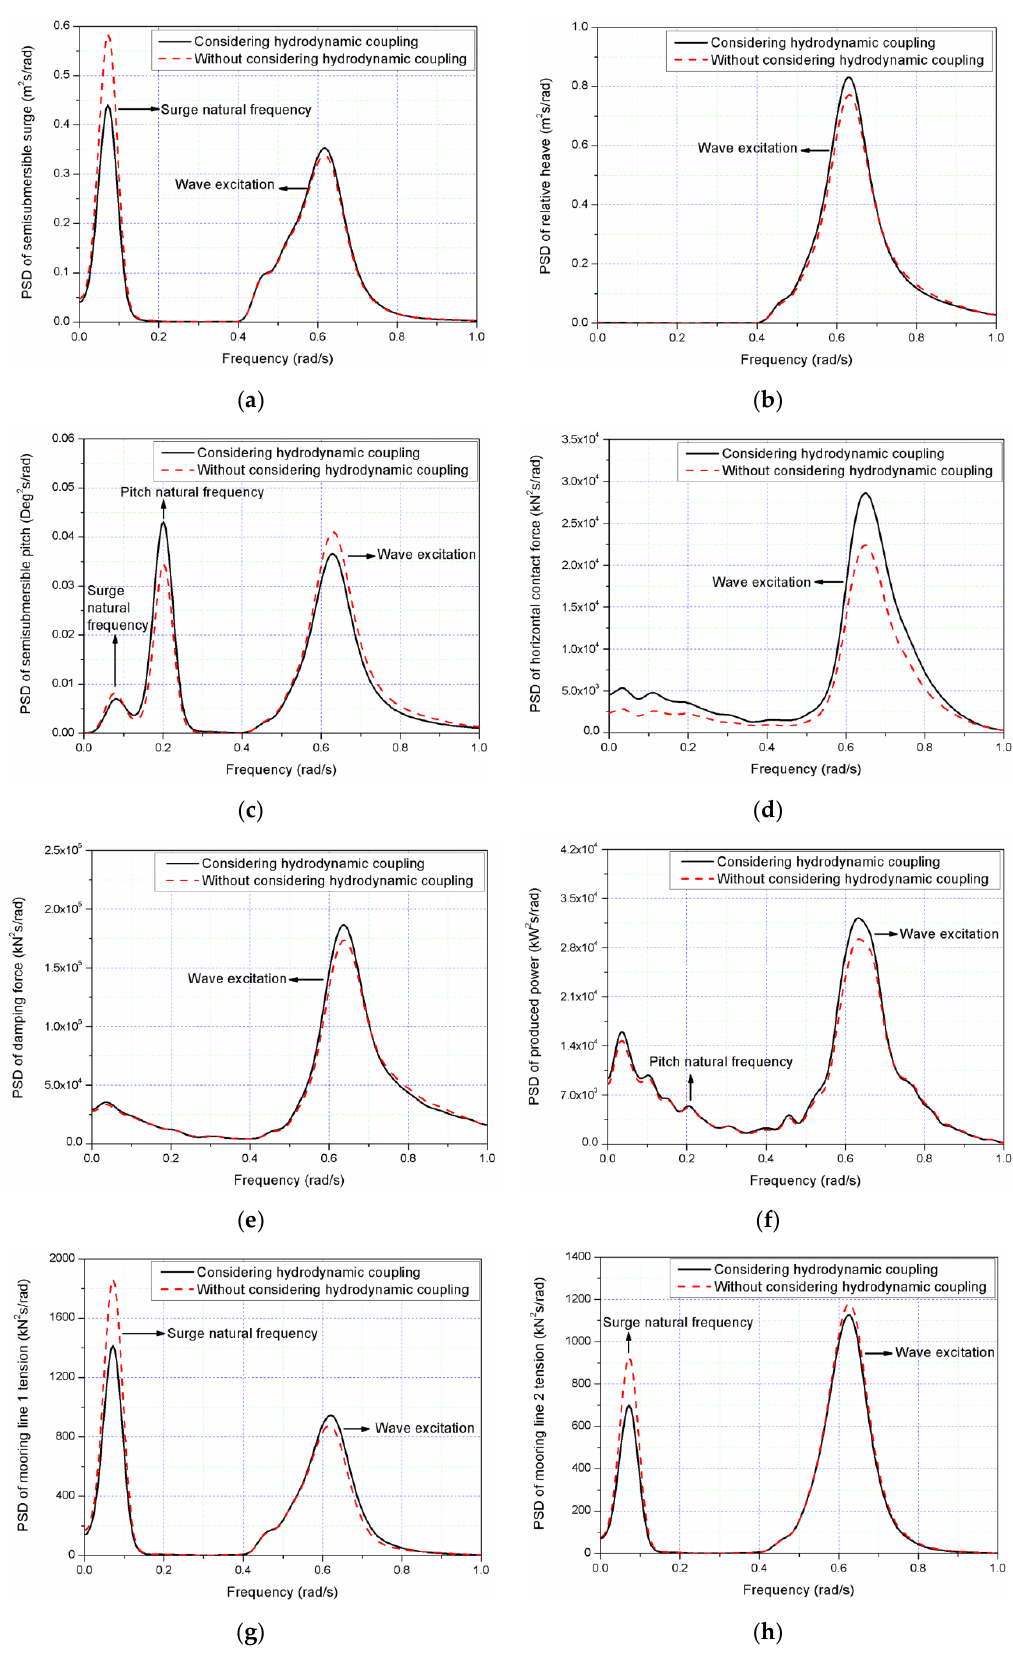
Figure 18. Power spectral density (PSD) of motion and dynamic responses for LC3: ( a ) semisubmersible surge; ( b ) relative heave; ( c ) semisubmersible pitch; ( d ) horizontal contact force; ( e ) damping force; ( f ) produced power; ( g ) mooring line 1 tension; ( h ) mooring line 2